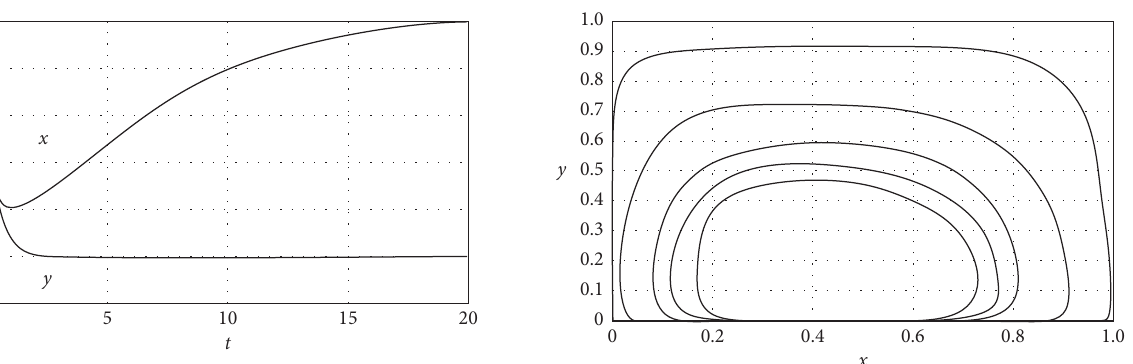
Figure 6: Dynamic evolution of government and enterprise strategy ( f ).